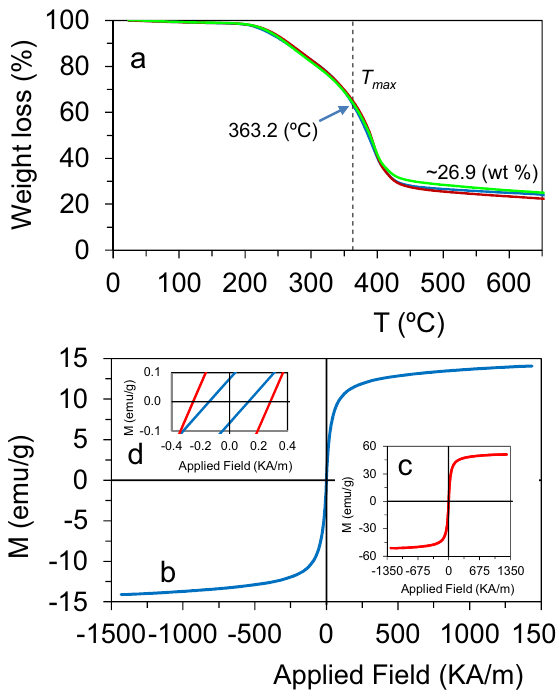
Figure 4. ( a ) TGA curves, in triplicate (red, blue and green curves), show the T max at around 363.2 ºC and the weight loss of the hybrid microgels which gives a content of pre-formed MNPs of around 26.9 (wt %), ( b ) Field dependant magnetization curve of hybrid microgels. The inset ( c ) corresponds to the magnetization curve for the uncoated Fe 3 O 4 NPs while the inset ( d ) is the coercivity ( Hc ) for coated and uncoated MNPs. Blue line: hybrid microgel; Red line: uncoated